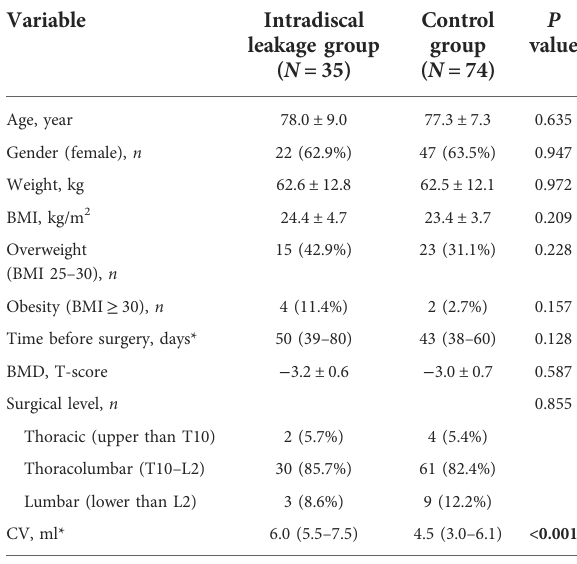
TABLE 2 Univariate analysis of demographic and perioperative baseline data for intradiscal